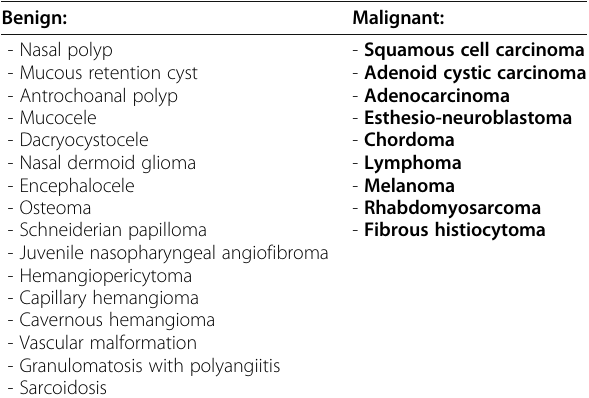
Table 2 Differential diagnosis established upon clinical, endoscopic, and radiological findings